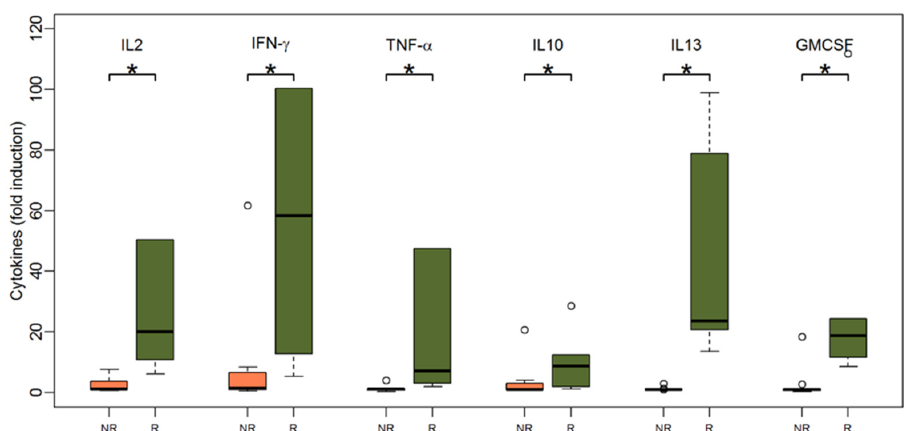
Figure 4. Boxplots showing the median and distribution of cytokines as detected by Luminex assay at baseline before vaccination for humoral non-responders (orange) and responders (green) after stimulation with TBE antigen (response was defined as NT ≥ 10 and at least two-fold increase in titer after two vaccinations). Asterisk marks significant p -value (IL2: p < 0.001; IFN-gamma: p = 0.003; TNF-alpha: p = 0.002; IL10: p = 0.04; IL13: p < 0.001; GM-CSF: p = 0.001).